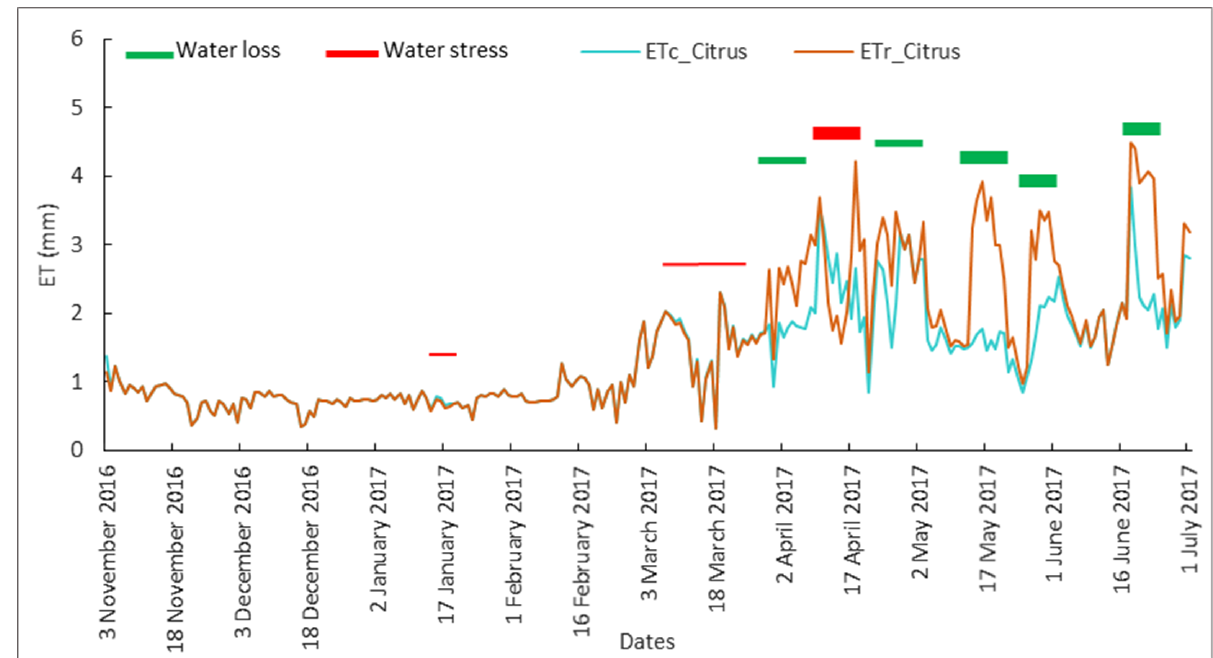
Figure 12. Comparison between ETc and ETr for citrus fruits .